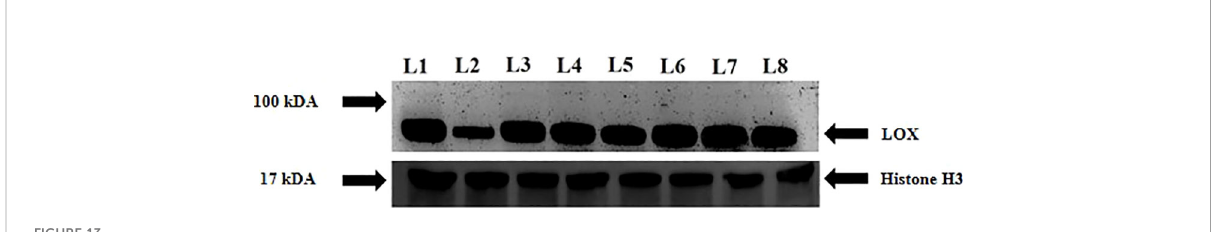
FIGURE 13 Immunoblot analysis of lipoxygenase in melatonin primed and unprimed plants of drought-sensitive (K-7) and drought-tolerant (K-9) varieties of Arachis hypogaea L. under optimal and drought stress conditions. Lane 1- K-7 control, Lane 2- K-7 stress, Lane 3- K-7 primed control, Lane 4- K-7 primed stress, Lane 5- K-9 control, Lane 6- K-9 stress, Lane 7- K-9 primed control and Lane 8- K-9 primed